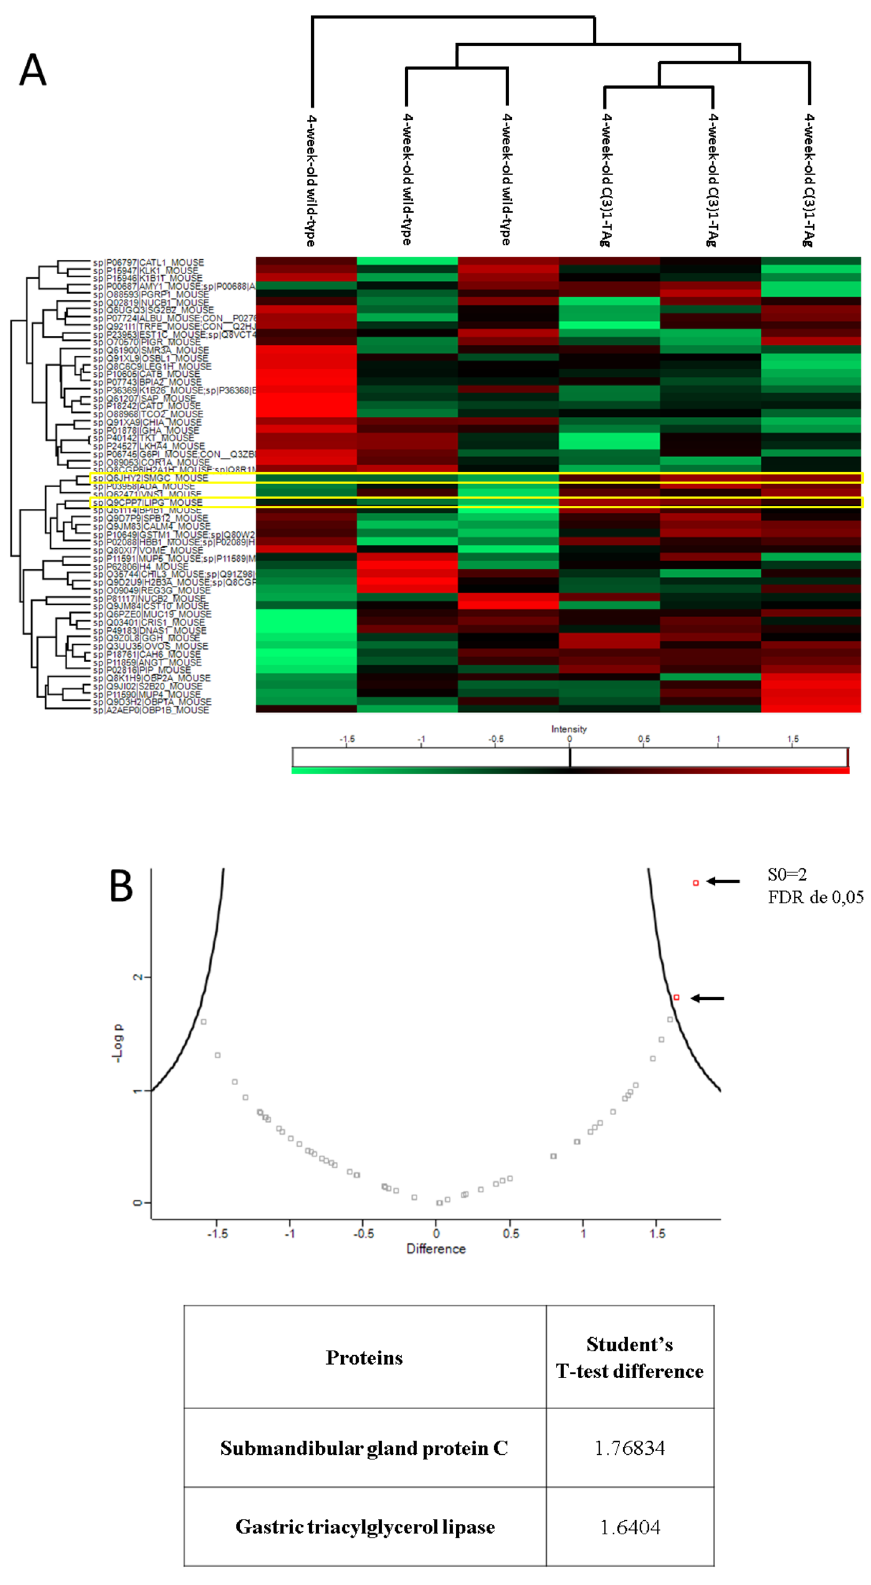
Figure 3. Protein expression in saliva of 4-week-old C(3)1-TAg females compared to age-matched wild-type. ( A ) Heatmap of protein expression in saliva comparing 4-week-old C(3)1-TAg with 4-week-old wild-type animals. The two proteins that are significantly higher expressed on 4-week-old C(3)1-TAg animals compared to 4-week-old wild-type mice are highlight in yellow. ( B ) Volcano plot showing two proteins (represented by red dots with arrows. Each red dot represents a separate gene) that are significantly higher expressed on 4-week-old C(3)1-TAg animals compared to 4-week-old wild-type